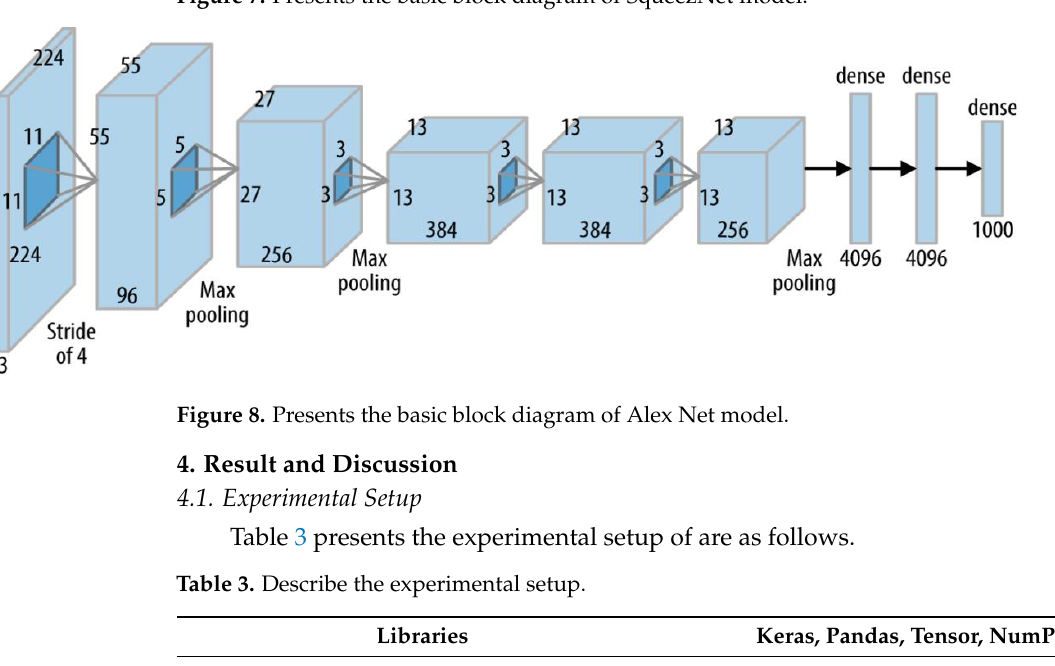
Figure 8. Presents the basic block diagram of Alex Net model.